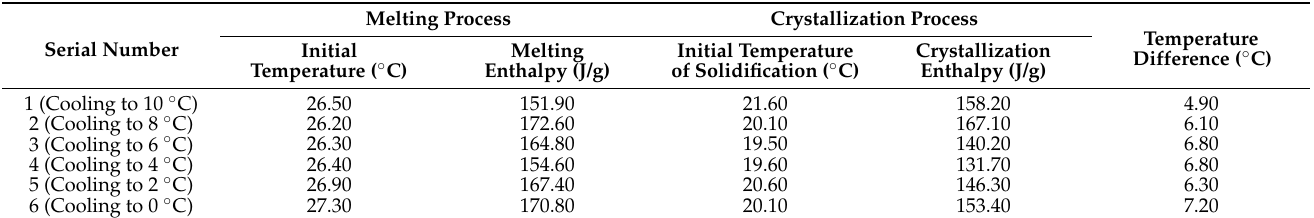
Figure 12. DSC characterization of phase transition properties of binary composite phase change materials at different cooling temperatures. ( a ) DSC curve of the second temperature rise. ( b ) Step cooling curve of the exothermic process.